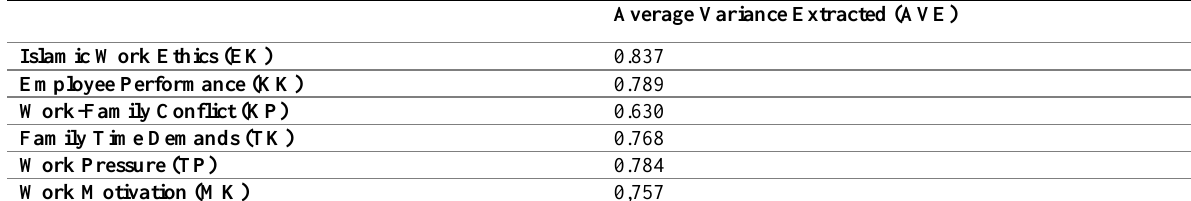
Table 3: Average Variance Extracted (AVE)